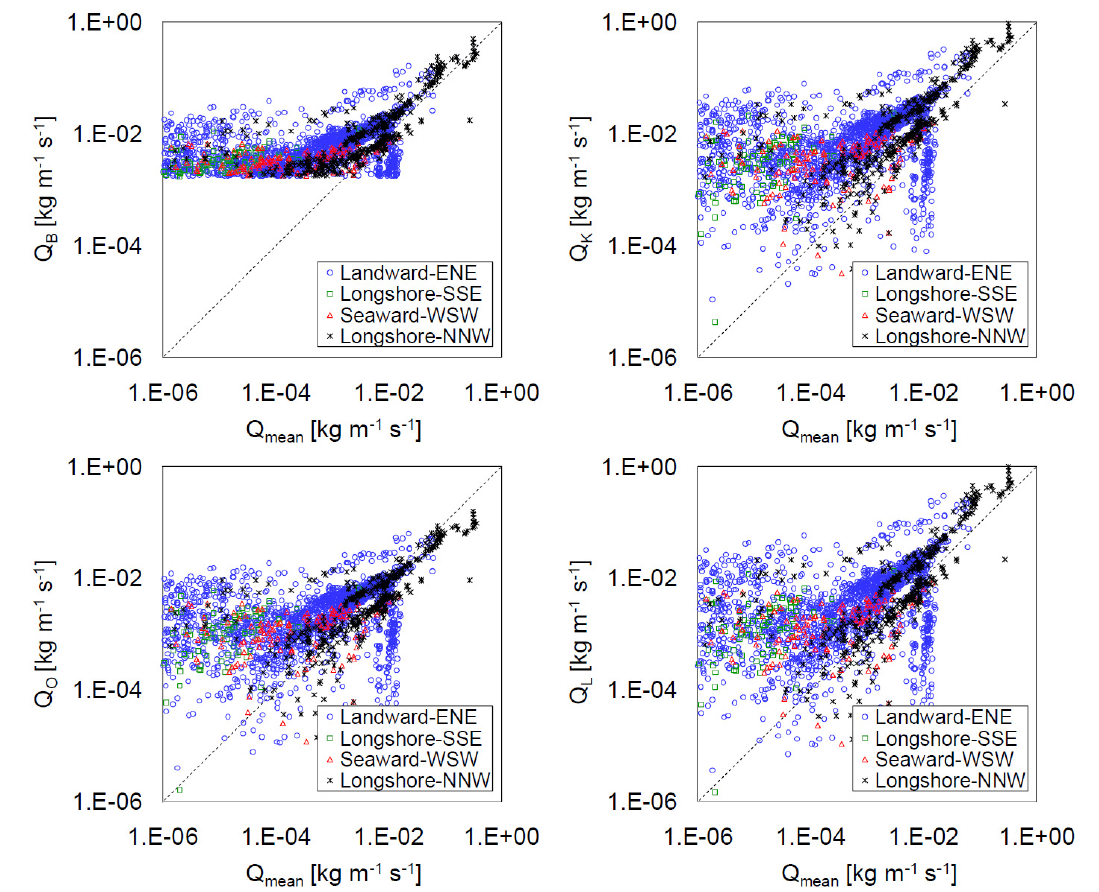
Figure 8. Comparison of Q estimated from n with Q mean < 105°), south-southeast (105° < θ east-northeast (15° < θ mean (195° < θ < 285°), and north-northwest (285° < θ mean or greater than 1.76 × 10 -3 kg m –1 s –1 because Equation (11) does not include the term ( u – u ). The dashed line denotes perfect agreement. * * t